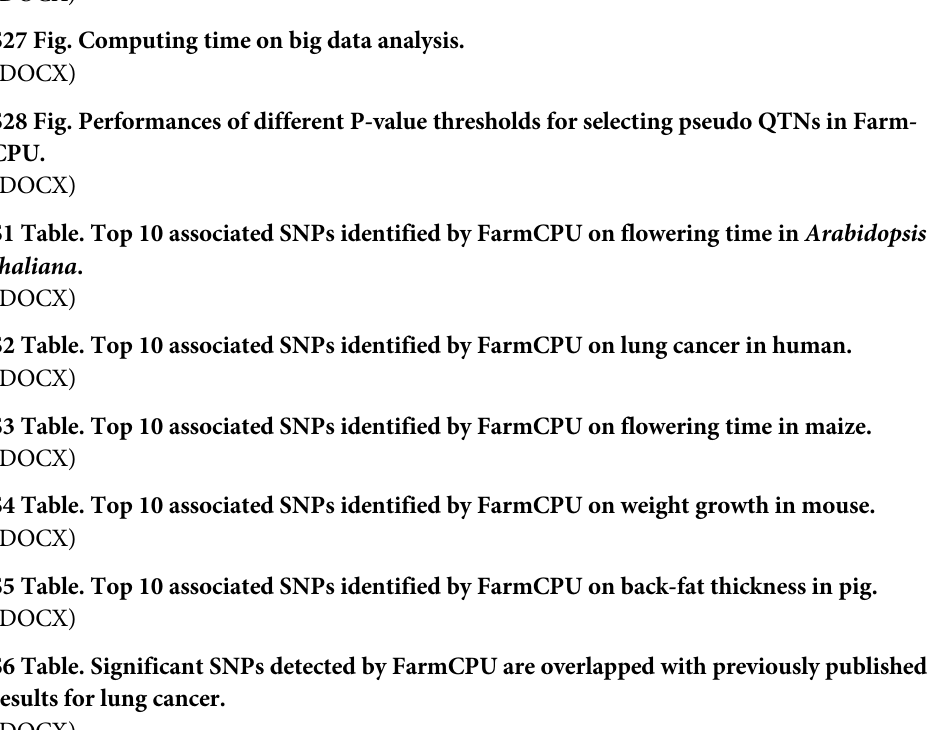
S23 Fig. Comparison of FarmCPU and GLM with varying levels of prior knowledge. (DOCX) S24 Fig. Impact of prior knowledge on the Power of FarmCPU. (DOCX) S25 Fig. Comparison of computing time and memory usage among five software packages. (DOCX) S26 Fig. Computing times for analyzing datasets with large numbers of individuals and large numbers of markers. (DOCX) S27 Fig. Computing time on big data analysis. (DOCX) S28 Fig. Performances of different P-value thresholds for selecting pseudo QTNs in Farm- CPU. (DOCX) S1 Table. Top 10 associated SNPs identified by FarmCPU on flowering time in Arabidopsis thaliana . (DOCX) S2 Table. Top 10 associated SNPs identified by FarmCPU on lung cancer in human. (DOCX) S3 Table. Top 10 associated SNPs identified by FarmCPU on flowering time in maize. (DOCX) S4 Table. Top 10 associated SNPs identified by FarmCPU on weight growth in mouse. (DOCX) S5 Table. Top 10 associated SNPs identified by FarmCPU on back-fat thickness in pig. (DOCX) S6 Table. Significant SNPs detected by FarmCPU are overlapped with previously published results for lung cancer. (DOCX) S7 Table. Observed number of false positives for FarmCPU (FC) versus t-test (T) at differ- ent P-value thresholds in simulation. (DOCX) S8 Table. Observed versus expected number of false positives for FarmCPU at different P- value thresholds in the null distribution. (DOCX) S9 Table. Observed versus expected number of false positives for FarmCPU at different P- value thresholds in a structured population. (DOCX) S10 Table. Computing time complexity among statistical methods for Genome-Wide Asso- ciation Studies.